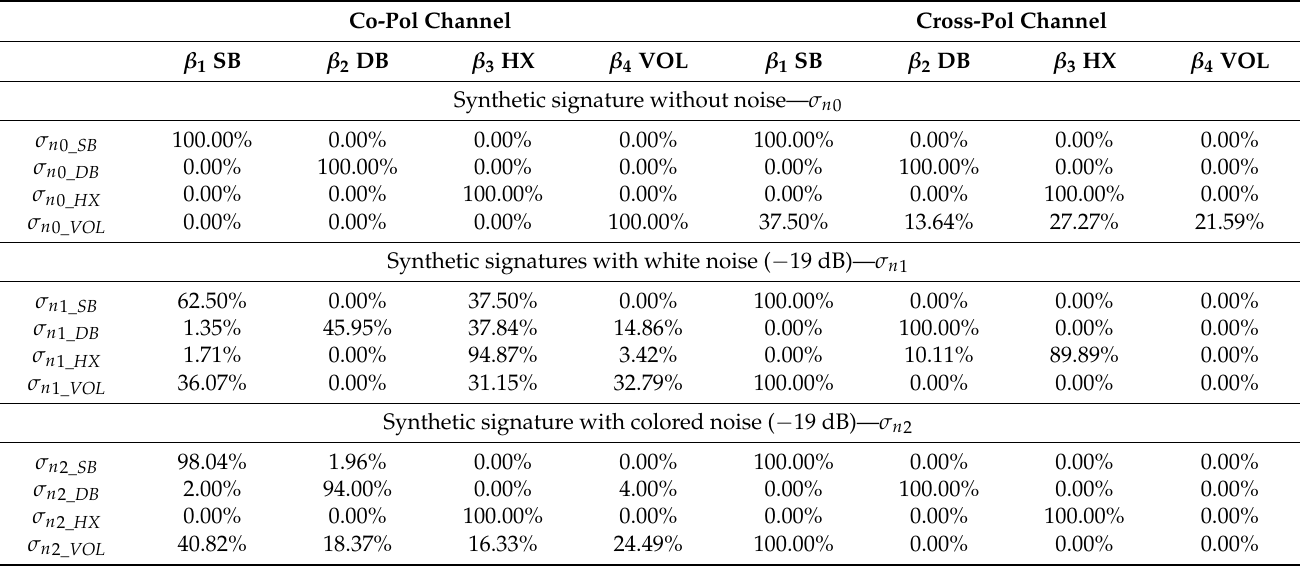
Table 3. Results of SIRT-based decomposition for synthetic polarimetric signatures (co- and cross- polarized channels). Recognized signatures are specified in percentage.